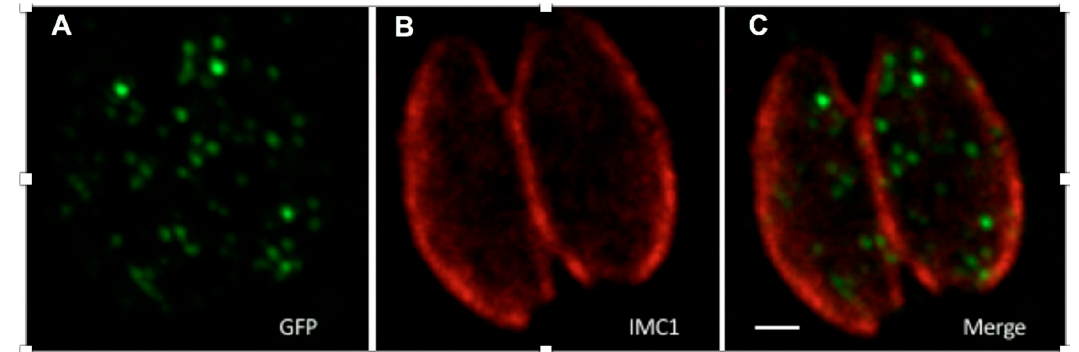
Figure 5. GFP tagged with ePTS1 localised in peroxisome-like bodies when transiently expressed in Toxoplasma. The image shows two parasites within a human fibroblast vacuole, GFP-ePTS1 stained with anti-GFP antibody ( A , green), the parasite pellicle stained with anti-IMC1 antibody ( B , red), and a merge of A and B ( C ). The scale bar is 1 µM.